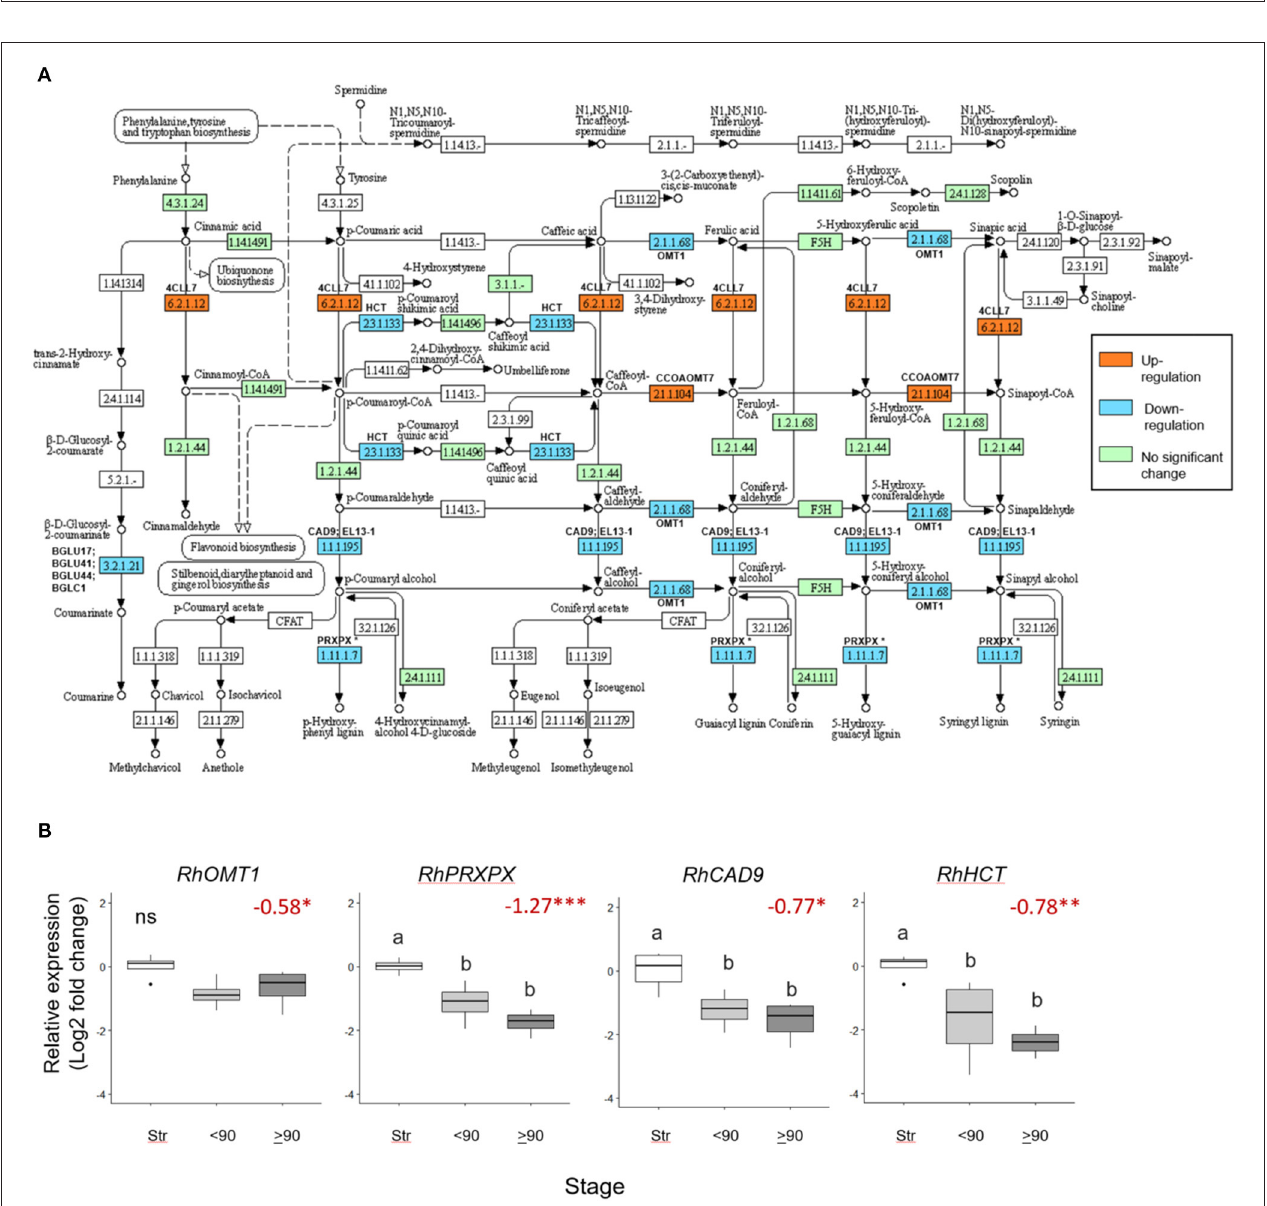
FIGURE 4 | EC codes shown in green represent enzymes within the R. chinensis genome with no significant change and EC codes in white represent enzymes not identified in R. chinensis . (B) qPCR relative expression of six galactose-related genes. Pfaffle analysis is relative to RhGACPC2 expression using straight peduncles as the control. Different letters indicate significant differences ( p < 0.05) based on one way ANOVA with a Tukey post hoc test and ‘ns’ indicates no significant difference. Red numbers indicate RNAseq Log2 FC (in brackets on the y-axis), where asterisks are *** p adjust . < 0.001, ** < 0.01, * < 0.05.